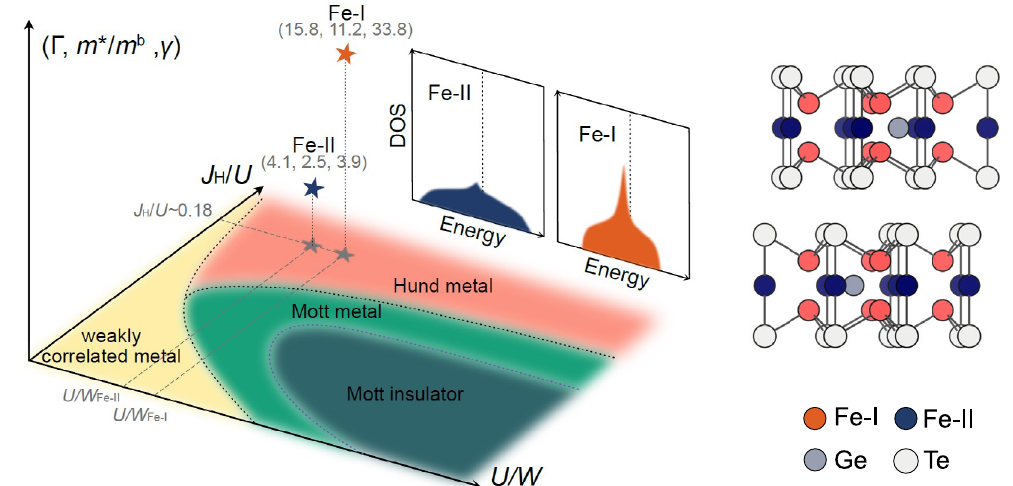
Fig. 1 Overview fi gure. Left panel: A schematic illustration of “ site-differentiated Hund metal ” physics in Fe 3 GeTe 2 . Colored areas highlight different regimes or phases; Mott insulator (dark green; i.e., whose charge gap is opened due to Hubbard U ), Mott metal (light green; i.e., whose correlated metallic behavior is governed by U ), weakly correlated metal (yellow; electronic correlation is weak enough), and Hund metal (red; i.e., whose correlated metallic behavior is governed by Hund J H ). For more details to de fi ne each region of the phase diagram, we refer to refs. 35,42,61 . While both Fe sites fall into the Hund metal regime, they are clearly differentiated in terms of electron scattering rate Γ , quasiparticle effective mass m * / m b , and Sommerfeld coef fi cient γ (as depicted along z axis) which are attributed to the electronic structure details (see the schematic DOS). In parentheses shown are the calculated spin-orbital-averaged values of ( Γ , m * / m b , γ ) taken at T = 100 K. The unit of Γ is meV. The x - and y axis corresponds to J H / U and U / W , respectively. U = 5.0 and J = 0.9 eV ( J H / U = 0.18) were used for both Fe-I and Fe-II; see “ Methods ” for a more detailed discussion. The effective bandwidth W Fe-I for Fe-I is found to be smaller than that of Fe-II through the analysis of the hybridization function (see the main text). A rough estimation of their difference based on the integrated DOS yields ~1.6 eV (see the main text). Right panel: Crystal structure of Fe 3 GeTe 2